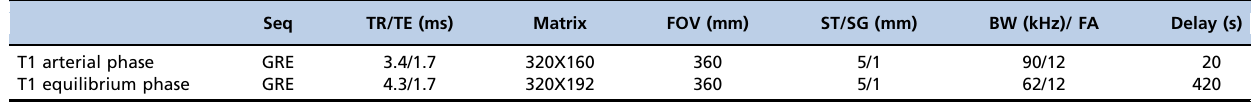
Table 1 - Magnetic resonance imaging parameters.